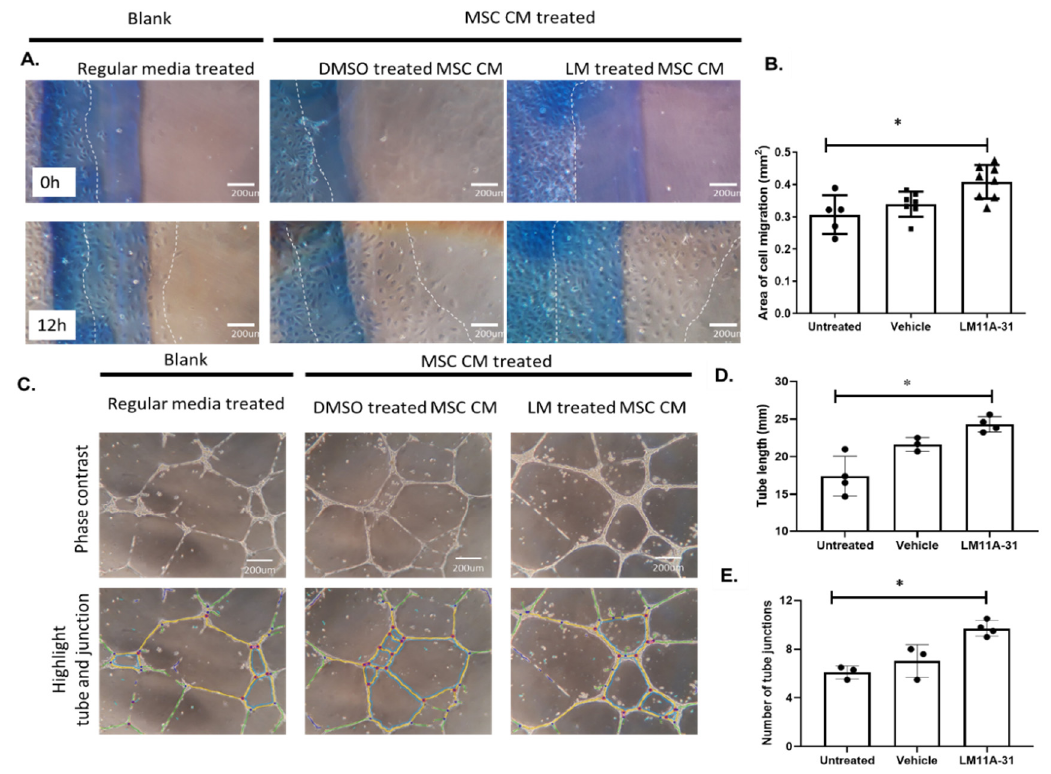
Figure 8. Conditioned medium of LM11A-31-treated MSCs improved angiogenic response in HREs. ( A , B ) Representative micrographs and statistical analysis of HREs migration shows a significant increase in HREs migration (distance marked from original plating line marked with blue pen) after 12 h treatment with CM of LM11A-31-modulated MSCs (*, significance using unpaired student t-test, n = 5–7). ( C – E ) Representative phase contrast images ( C ) and statistical analysis for tube length ( D ) and number of tube junction ( E ) formed in vitro by HREs after 24 h treatment with CM of LM11A-31-modulated MSCs. Results showed a significant increase in tube length and number of tube junctions (*, significance using unpaired student t-test, n = 3).